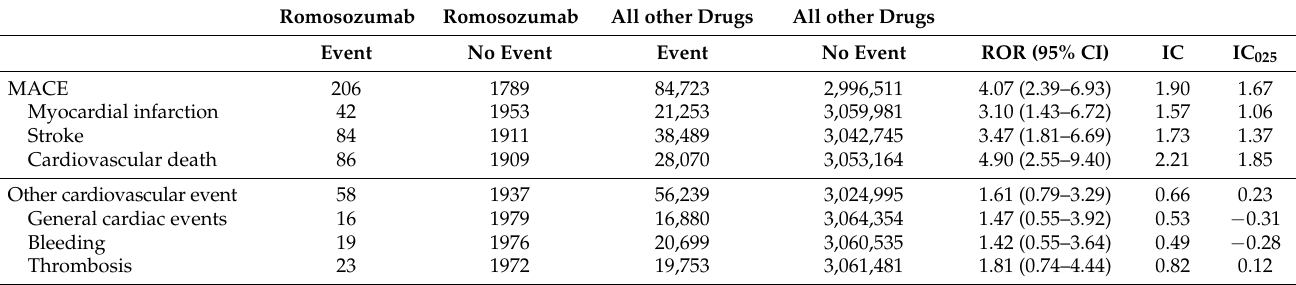
Table 3. Disproportionality analysis for the outcomes of interest, comparing events with romosozumab to events with all other drugs in the Food and Drug Administration Adverse Event Reporting System (FAERS) between 01 January 2019